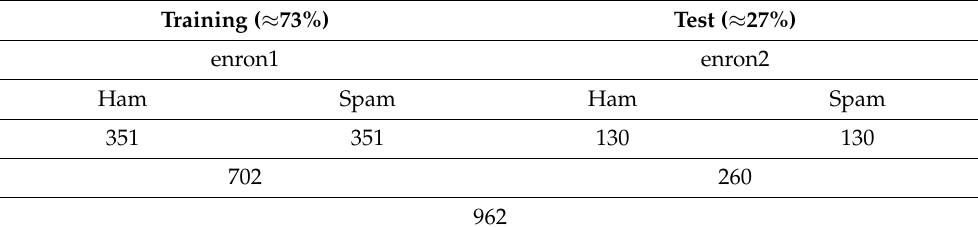
Table 4. Dataset 1 structure.